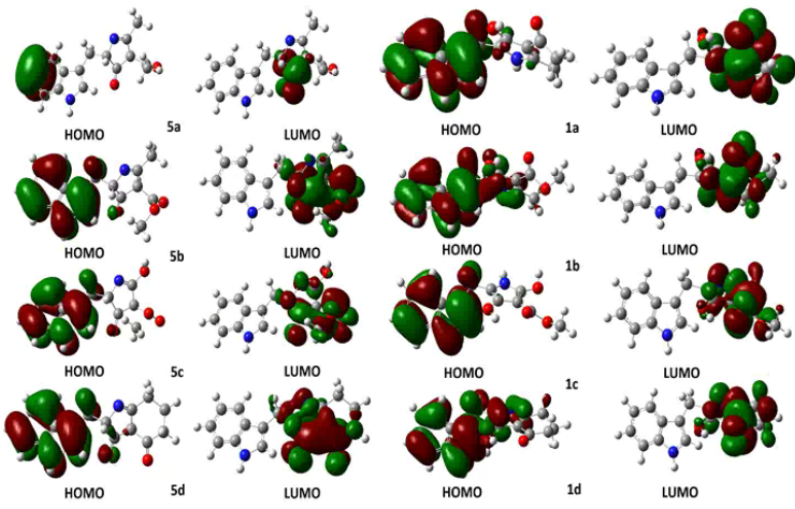
Figure 2. Frontier HOMO and LUMO representations for 2,4,5-trisubstituted-1 H